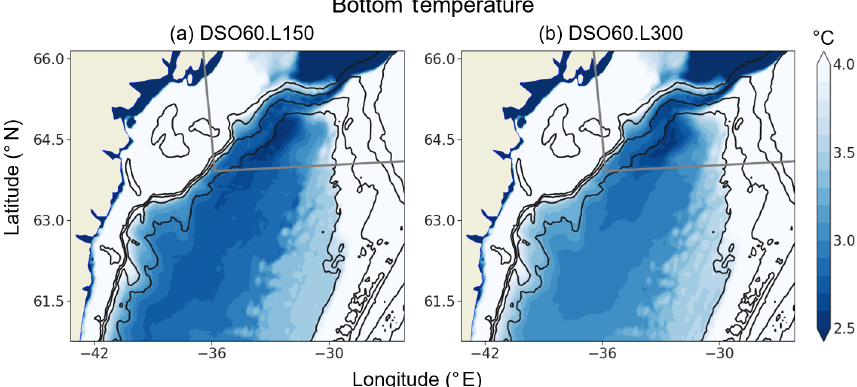
Figure 12. Annual mean of the bottom temperature in the fifth year of simulations using a grid refinement of 1 / 60 ◦ for (a) 150 vertical levels (DSO60.L150) and (b) 300 vertical levels (DSO60.L300). Isobaths 500, 1000, 1500, and 2000m are contoured in black. The grey box indicates the area of refinement.